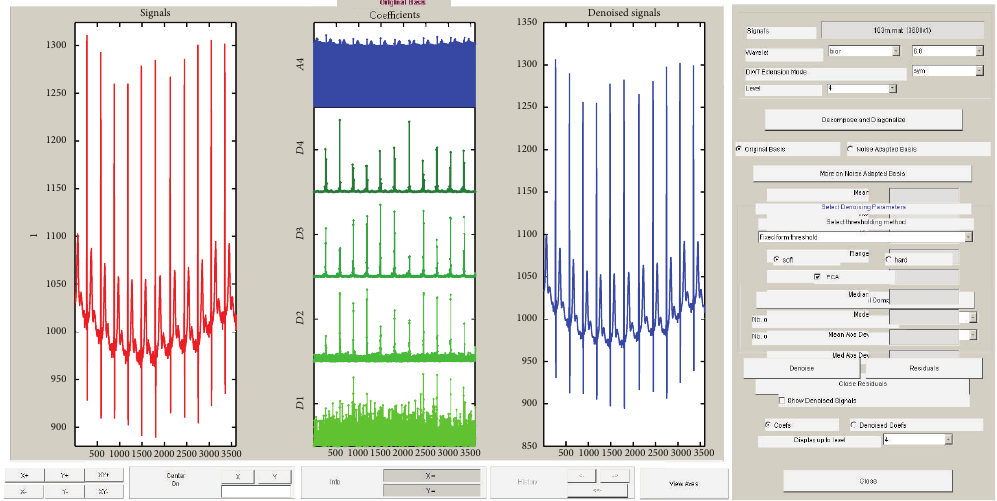
Figure 6: Multiwavelet denoising for ECG record no 103 m using Biorthogonal 1D wavelet.